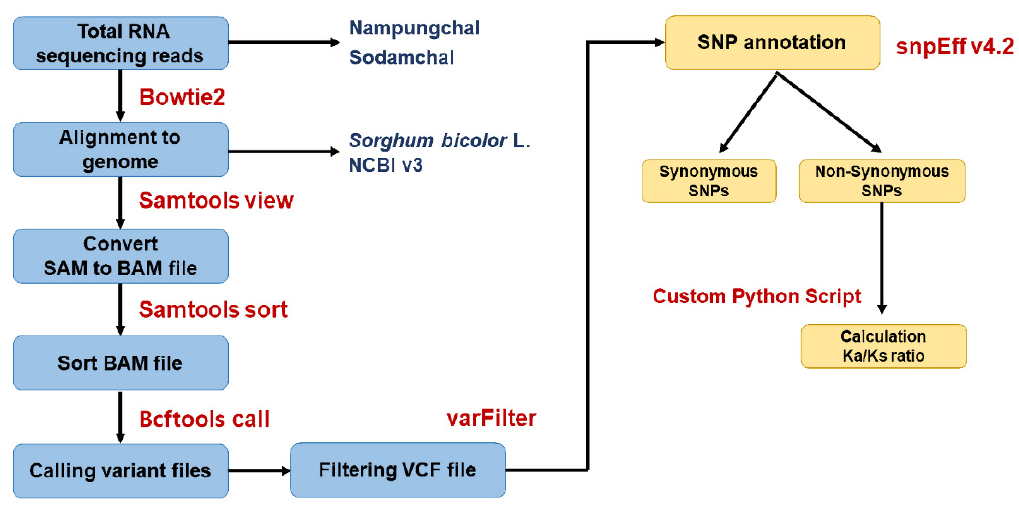
Figure 1. Calling and analysis workflow of SNPs, using various bioinformatics tools .